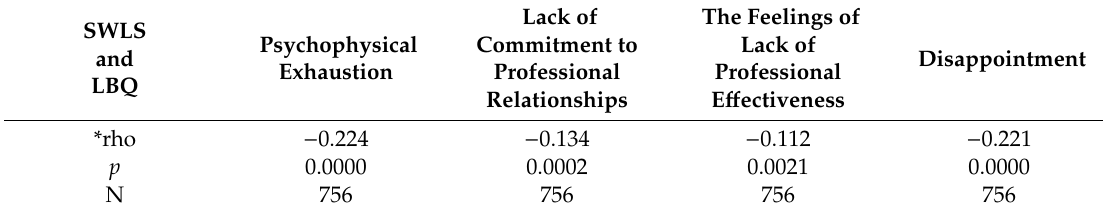
Table 8. Satisfaction with life and the level of occupational burnout among nurses (SWLS vs. LBQ).